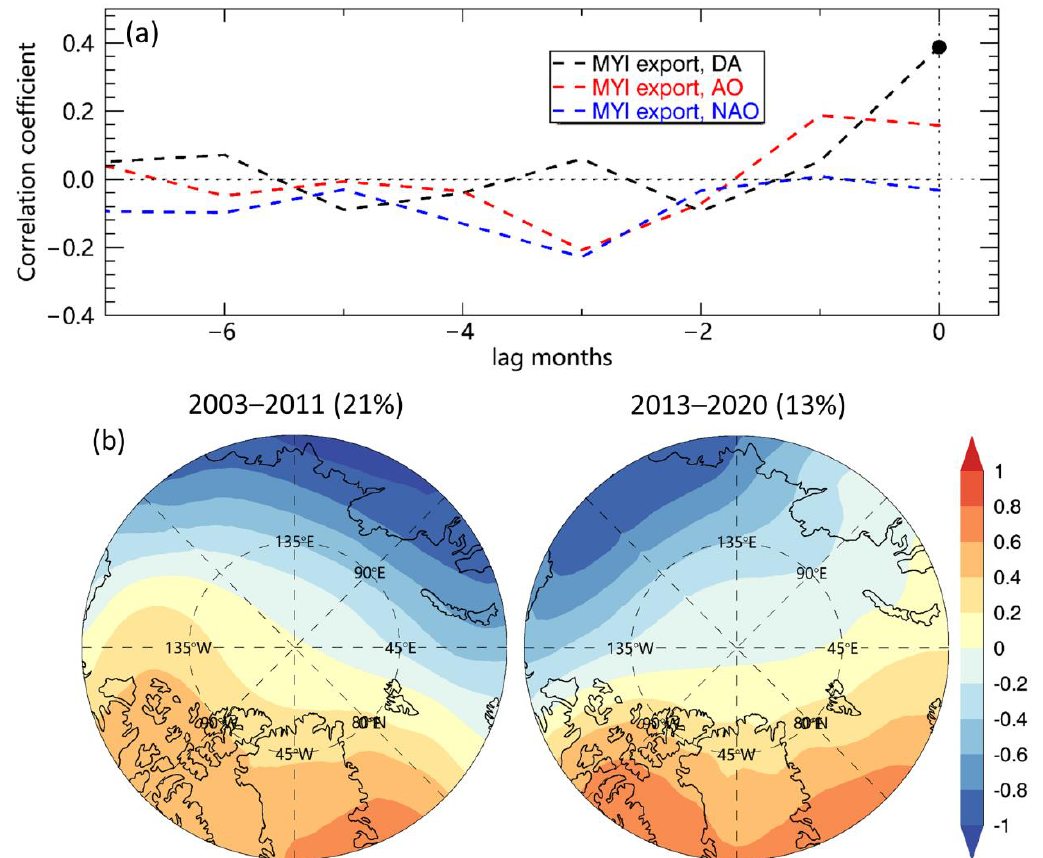
Figure 8. Linkages between MYI export and large-scale atmospheric circulation. ( a ) Correlations as a function of lag months between monthly MYI area export anomalies the indices of DA, AO, and NAO. The black circle represents confidence levels above 95%. Negative lags represent the MYI area export lagging. ( b ) The eigenvectors of the second modes of monthly mean SLP north of 70°N in winter during D1 and D2, accounting for 21% and 13% of the total variance, respectively.